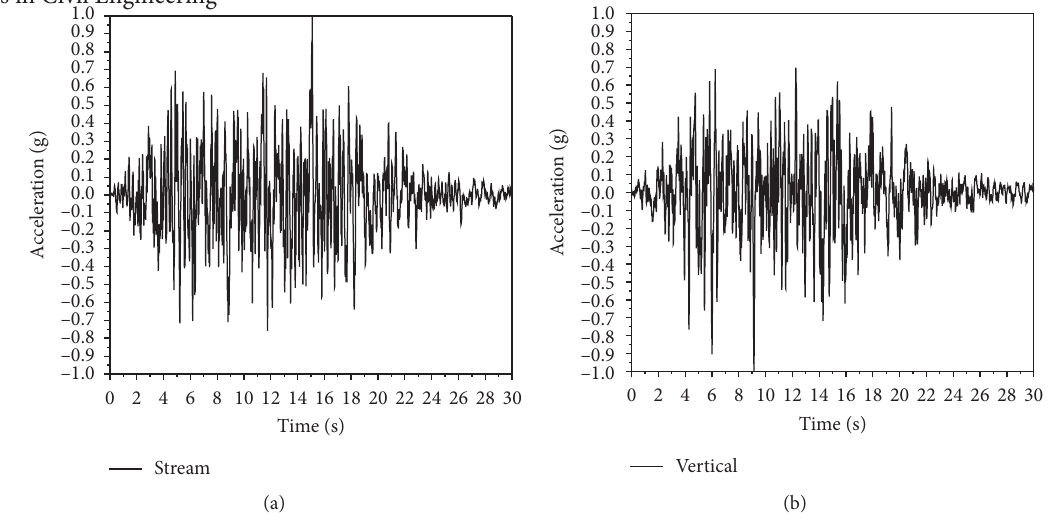
Figure 2: The normalized artificial acceleration time